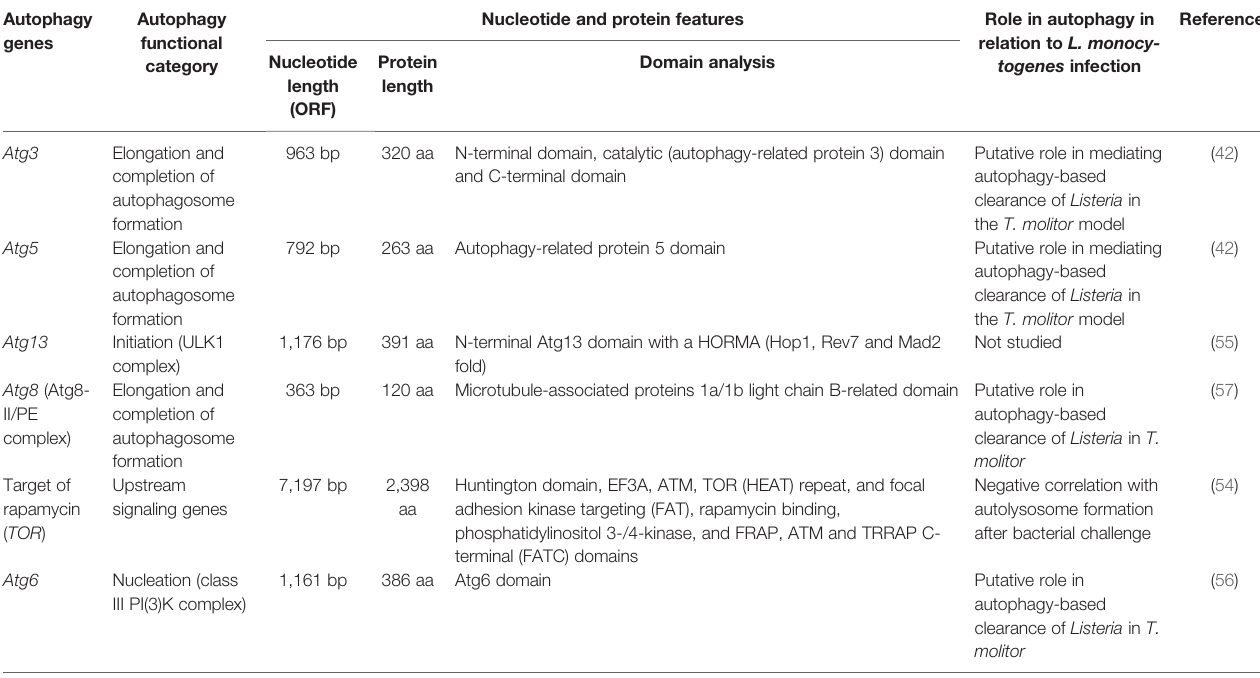
TABLE 5 | Summary of the autophagic signatures functionally characterized in T. molitor implicated in autophagy-mediated clearance of the gram-positive bacterium L. monocytogenes . Autophagy